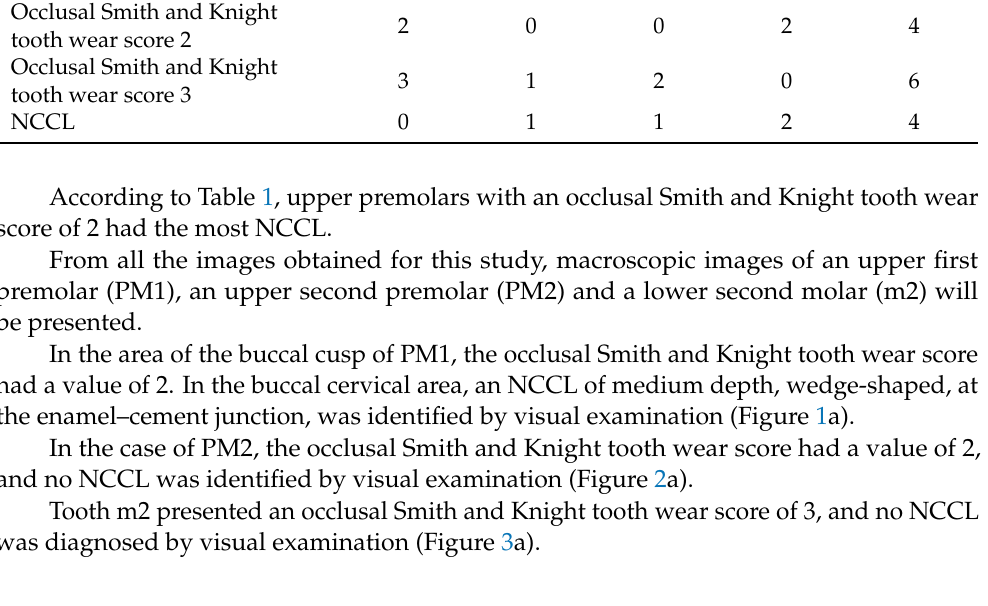
Table 1. NCCL distribution according to tooth type and occlusal wear index. Nr. of teeth included in study